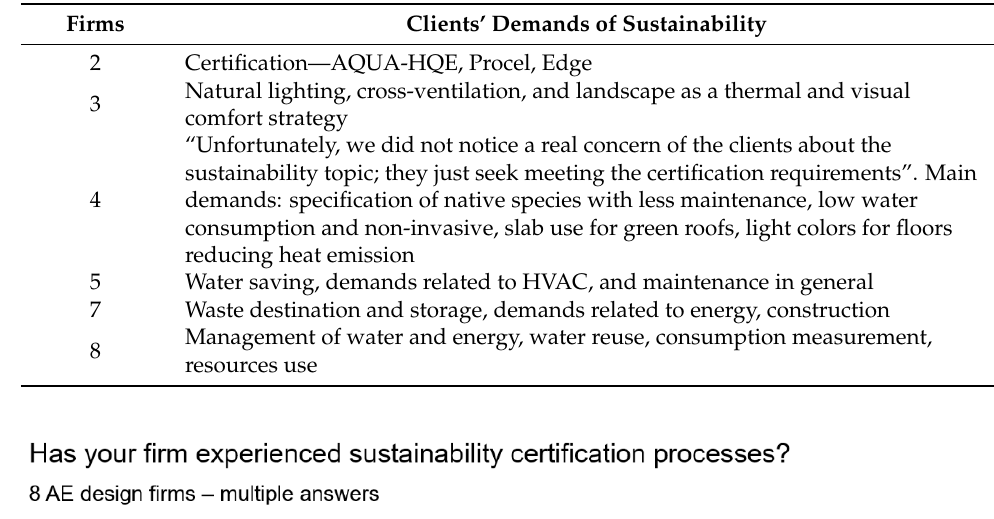
Table 2. Demands of sustainability aspects.